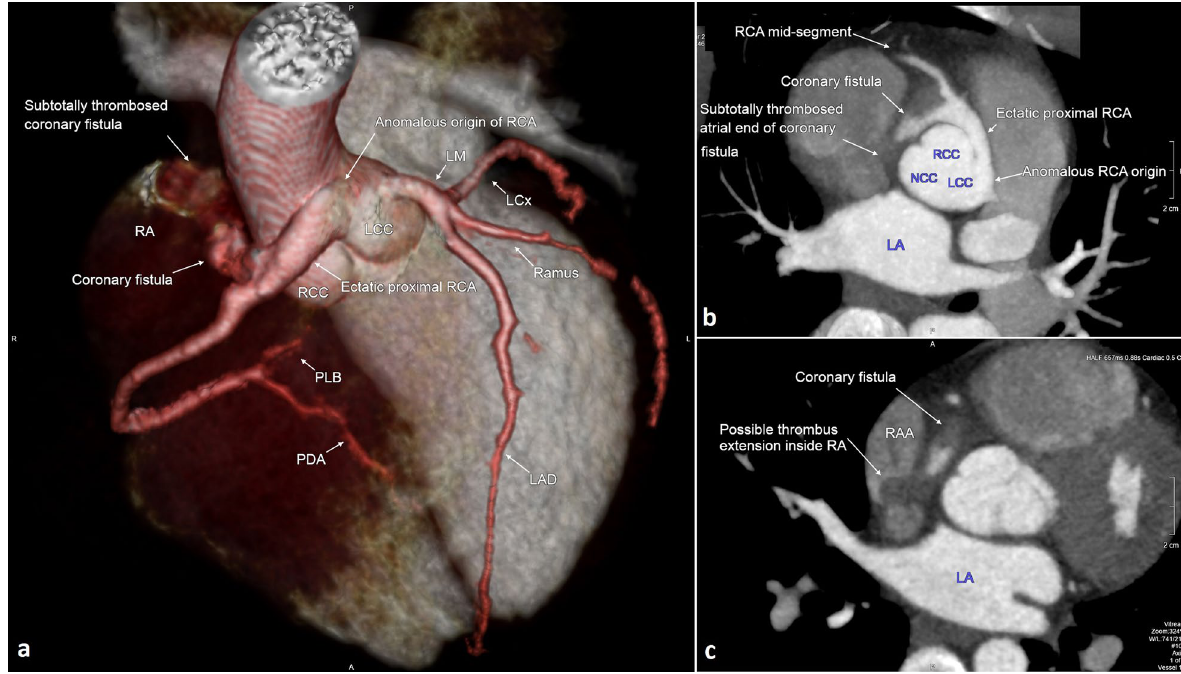
Fig. 4 Subtotally thrombosed large proximal RCA fistula with right atrium together with anomalous origin of RCA in 21-year-old male with palpitations. Semitransparent 3D volume rendered image ( a ) showing anomalous origin of ectatic RCA arising from left coronary cusp with faintly opacified coronary artery fistula draining into right atrium due to subtotal thrombosis. Axial oblique MIP image ( b ) at the level of aortic root shows the anomalous origin of RCA and its malignant interarterial course with subtotal thrombosis of proximal RCA fistula. Axial oblique MIP image ( c ) at higher level reveals the remaining length of the subtotally thrombosed proximal RCA coronary fistula with its draining site into right atrium with possible extension of thrombus tail inside right